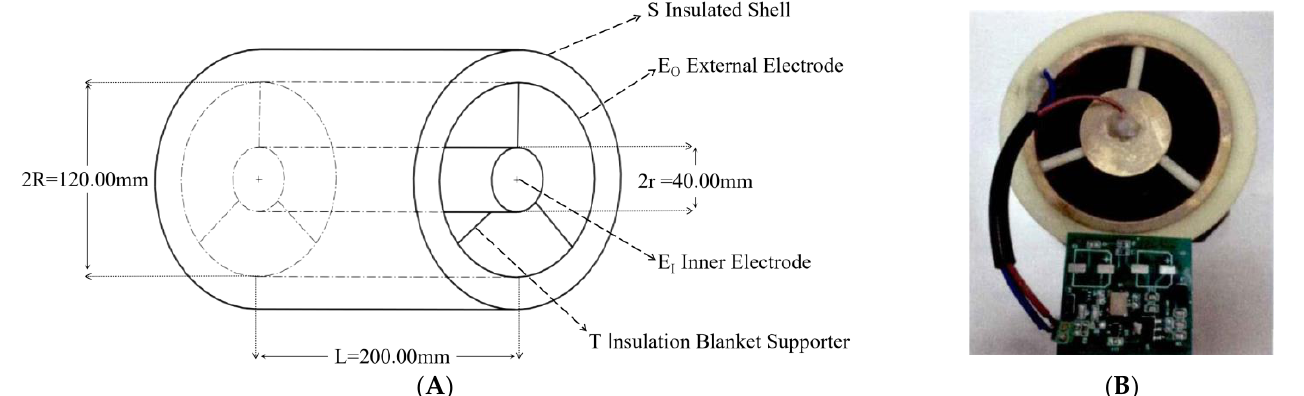
Figure 1. Fertilizer solution detection sensor. ( A ) The structural diagram. ( B ) The physical map.